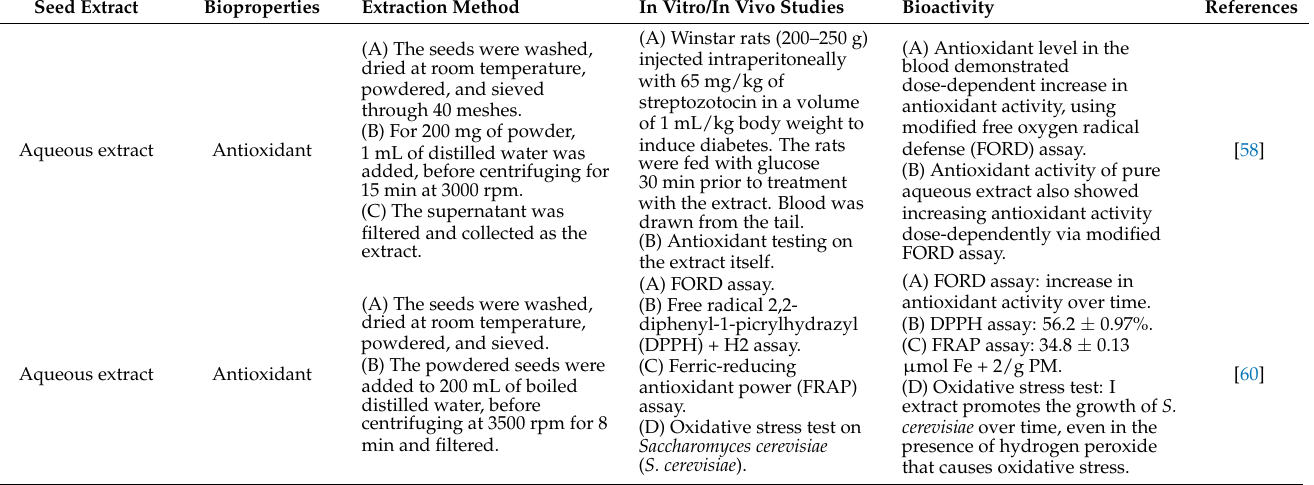
Table 2. The bioproperties and bioactivities of S. macrophylla seed that has cosmeceutical